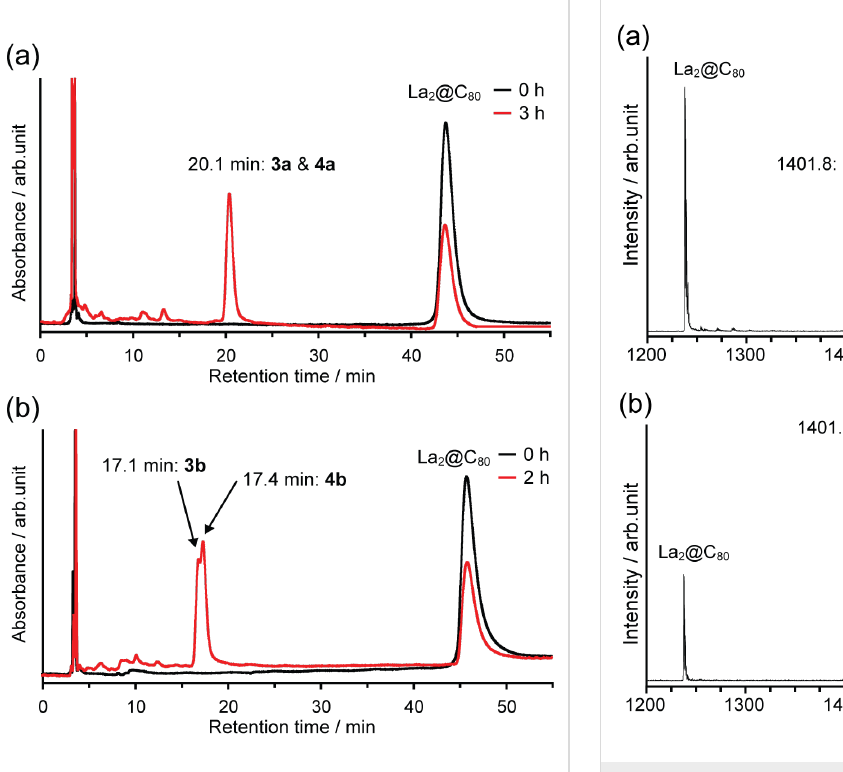
Figure 1: HPLC profiles of the reaction solutions (black) before and (red) after the reaction of La 2 @C 80 and (a) 1a and (b) 1b , respectively. Conditions: column, Buckyprep (Ø 4.6 mm × 250 mm); eluent, toluene; flow rate, 1.0 mL/min; wavelength: 330 nm; rt.